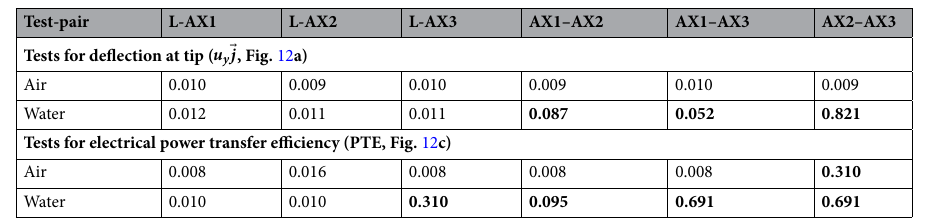
Table 2. Was there significant difference in tip-deflection between the lancet (L) and the axi-symmetric bevels a (AX1–3)? . a Each pair of bevels (e.g. L vs. AX1) were tested using a two-sample, two-sided, Wilcoxon rank sum test, n = 5, 5% error rate, significance level was 0.017 ( Bonferroni -corrected). Bolded entries indicate no statistical significance found between bevel pair (i.e. p 0.017). ≥